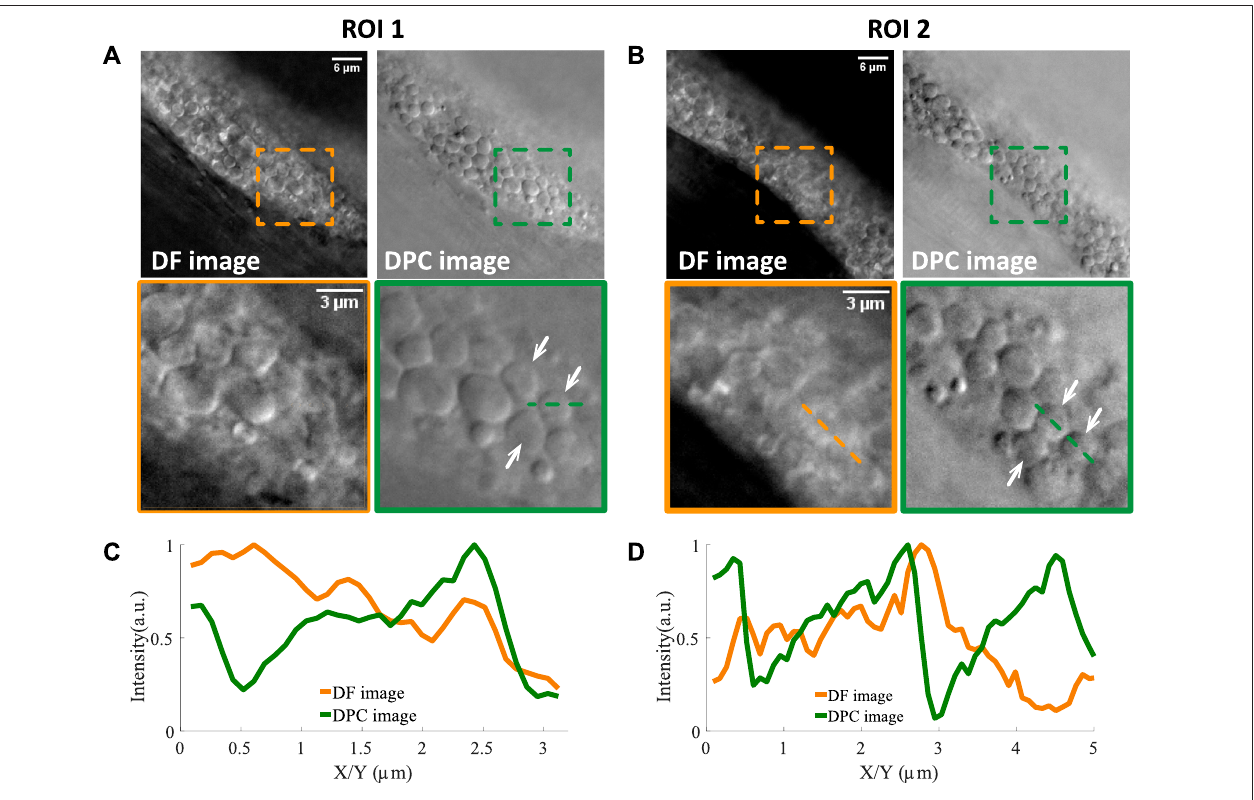
FIGURE 2 | Two examples of lipid droplets in dense regions imaged by normal dark fi eld microscopy and asymmetrically illuminated dark fi eld microscopy. (A,B) Two regions of interest and their zoom-in versions where lipid droplets pointed by the white arrows can be resolved in the DPC image and not in the DF image. The line pro fi les of two such lipid droplets are shown in (C,D) . Scale bars in (A,B) represent 6 μ m .